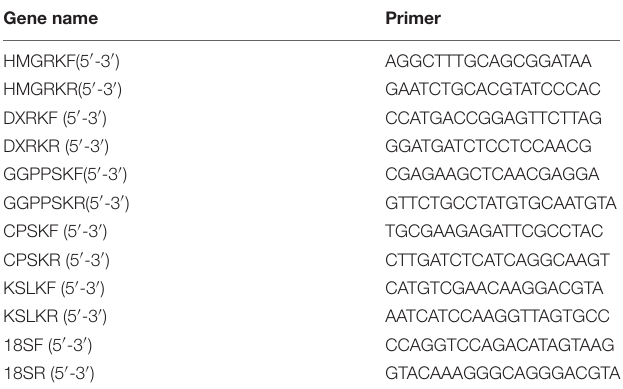
TABLE 1 | Primers used in real time-PCR.